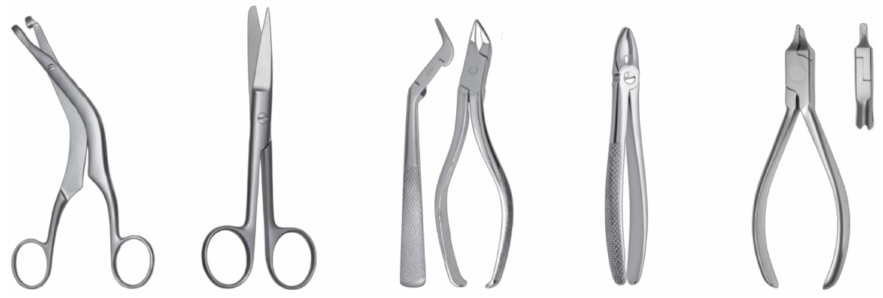
Figure 1. Examples of different shapes of surgical